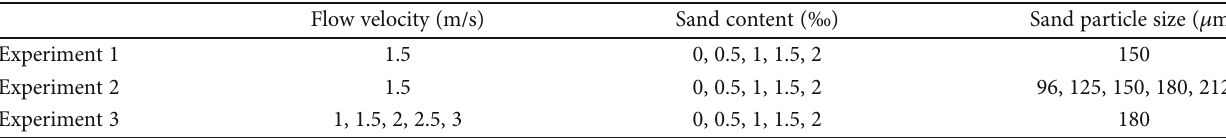
Figure 2: Schematic diagram of the experimental facility. Table 1: Experimental